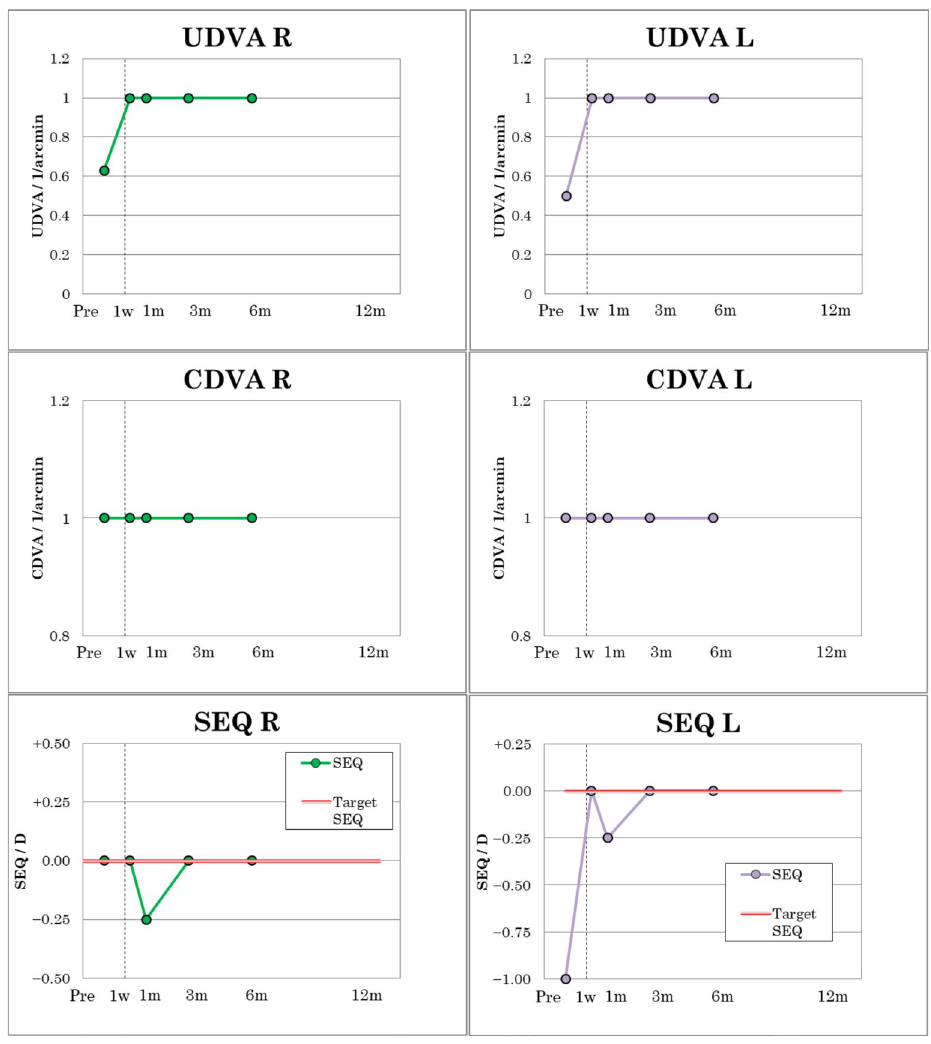
Figure 5. Visual outcomes of patient No. 2. Table 4. Summary of visual outcomes of patient